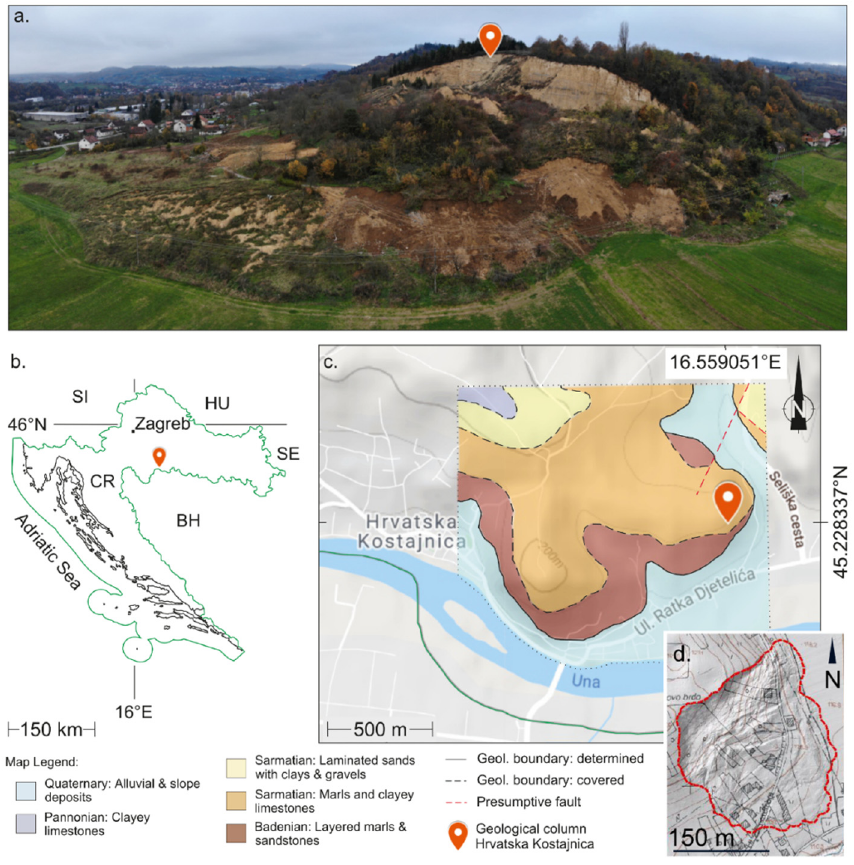
Figure 2. Study area: ( a ) landslide panorama in Hrvatska Kostajnica—on the south-eastern slope of Kubarnovo brdo, photo taken by unmanned aerial vehicle (UAV), by Croatian Geological Survey (CGS); ( b ) landslide location is in Croatia, near the border with Bosnia and Herzegovina; ( c ) basic geological data [23,24]; and ( d ) detail from topographic map (before landslide) overlaid with landslide area and detailed hillshade DEM (after landslide) and houses within landslide area: destroyed and damaged. Landslide area was defined by Croatian Geological Survey (CGS).